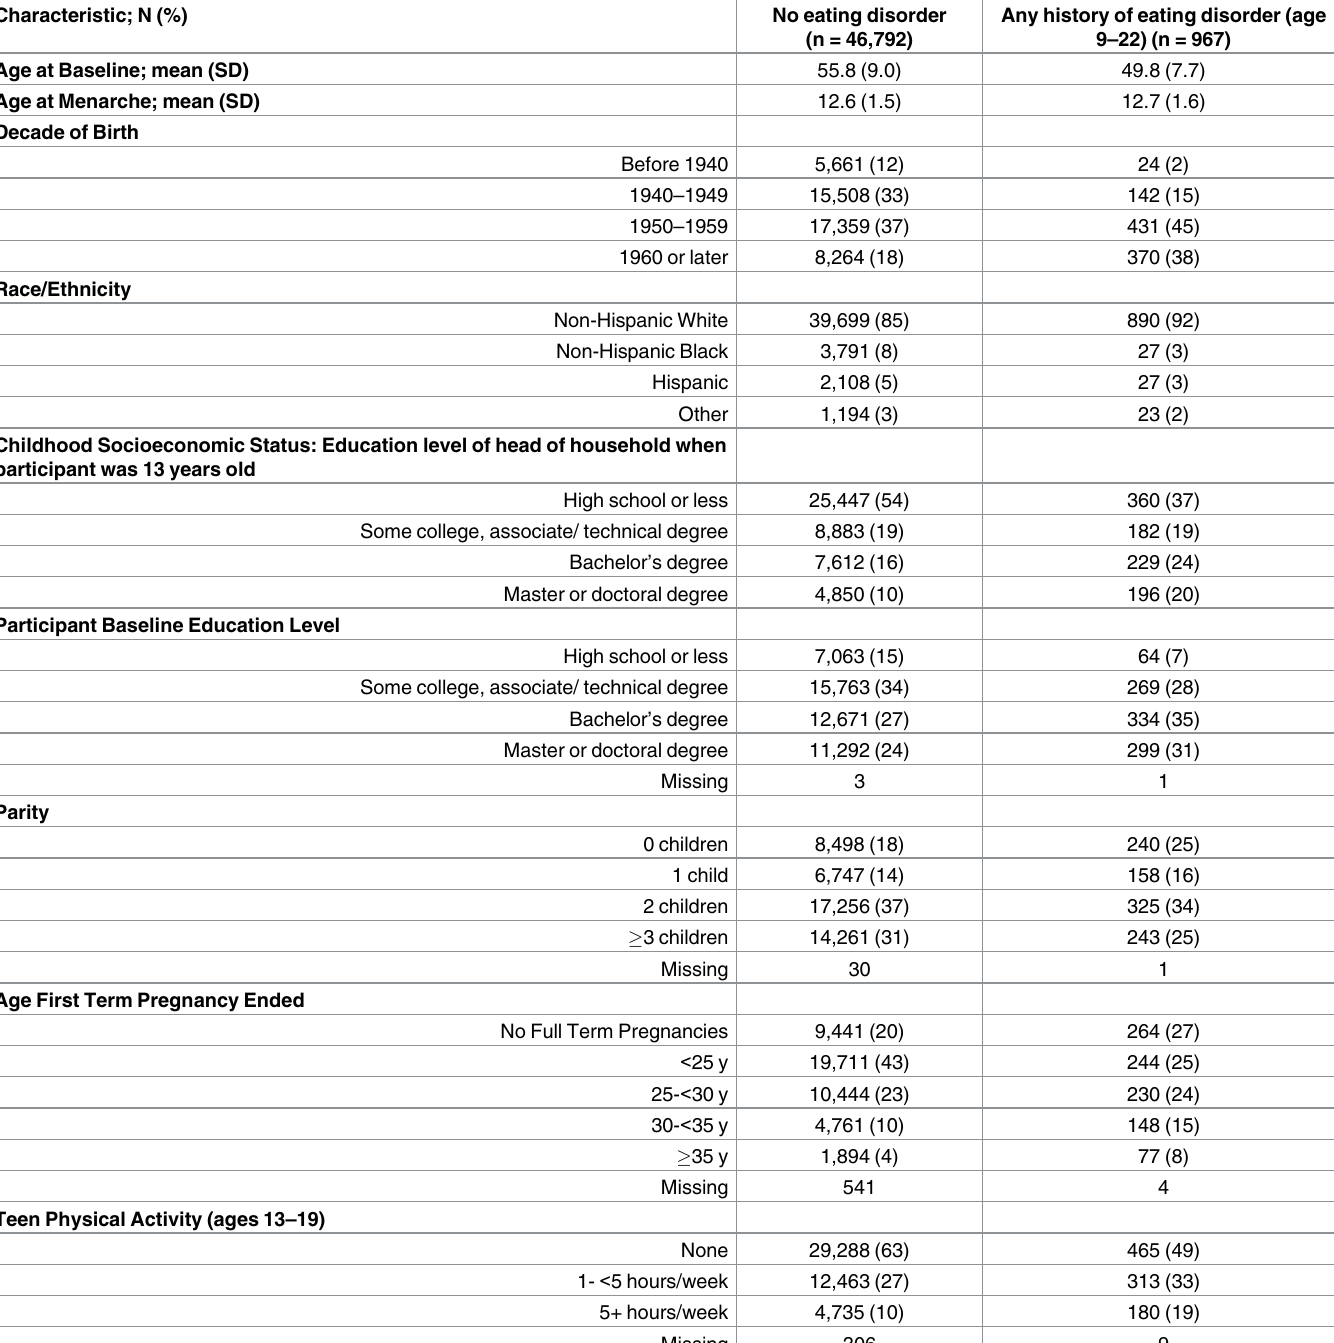
Table 1. Baseline characteristics of Sister Study participants (2003–2009) a